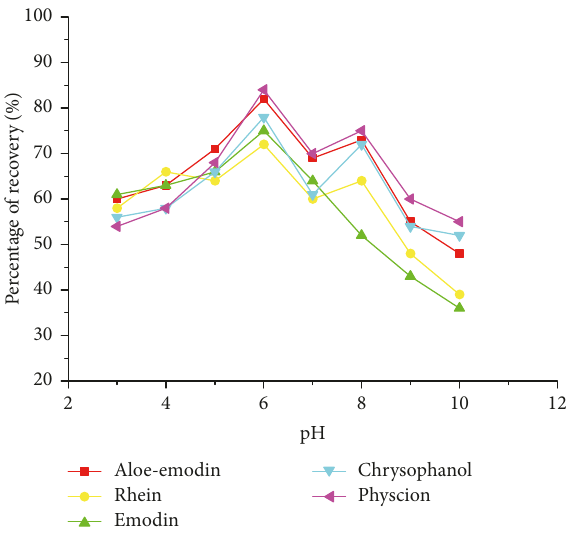
Figure 5: Effect of sample pH on the recovery of anthraquinones.